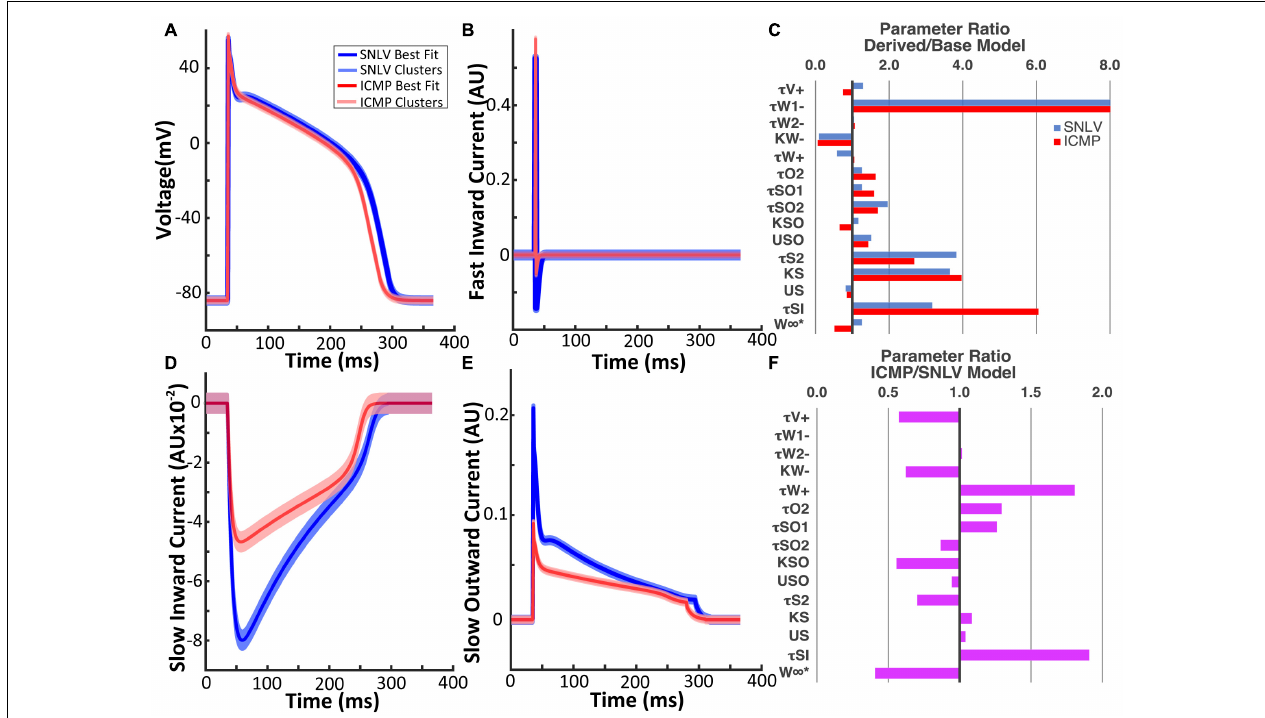
FIGURE 2 | (A) Action potential waveform of the SNLV and ICMP models. (B) Fast inward current waveform of the SNLV and ICMP models. (D) Slow inward current waveform of the SNLV and ICMP models. (E) Slow outward current waveform of the SNLV and ICMP models. Waveforms in (A,B,D,E) are derived from cell-level simulations during pacing at 500 ms. Bold blue and red lines represent the waveforms of the best fit models, while light blue and red lines represent the wavefronts using the centroids of the six highest clusters. Jitter has been applied to the waveforms using the centroids of the six highest clusters to facilitate visualization. (C) Fold-difference of the parameters of SNLV (blue) and ICMP (red) compared to the endocardial parameter set of the baseline BOFC model. The parameter τ w 1 − of SNLV and ICMP models is 16.6- and 16.7-fold higher than the baseline BOFC model but the bar chart has been truncated at 8 for better visualization of the remaining parameters. (F) Fold-difference of the parameters of ICMP compared to SNLV models.